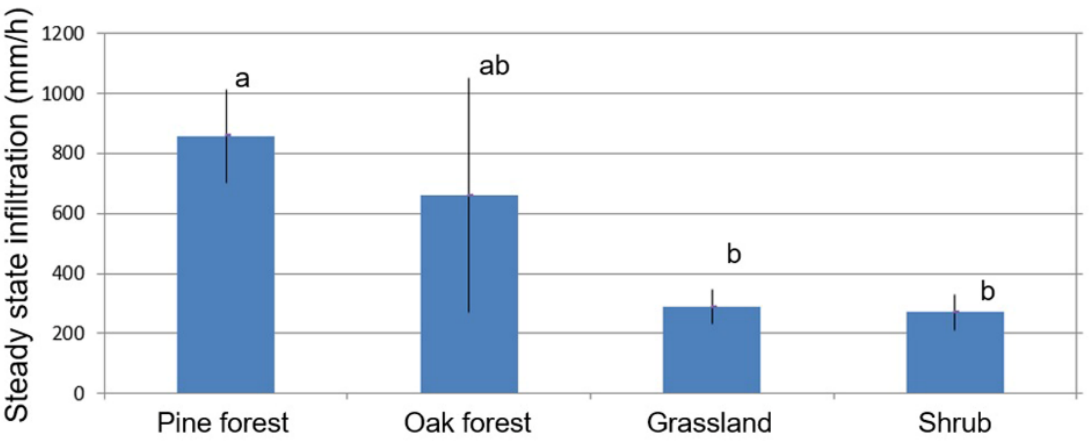
Figure 7. Mean plot of the steady state infiltration rate for the vegetation types. Error bars represent 95% confidence intervals. Different letters denote statistically significant differences, α = 0.05.